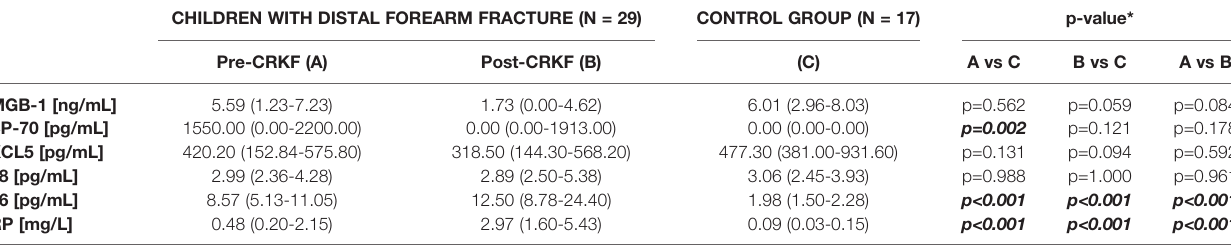
TABLE 2 | DAMPs, in fl ammatory cytokines and CRP concentration results in plasma of children with distal forearm fracture and in the control group. CHILDREN WITH DISTAL FOREARM FRACTURE (N =